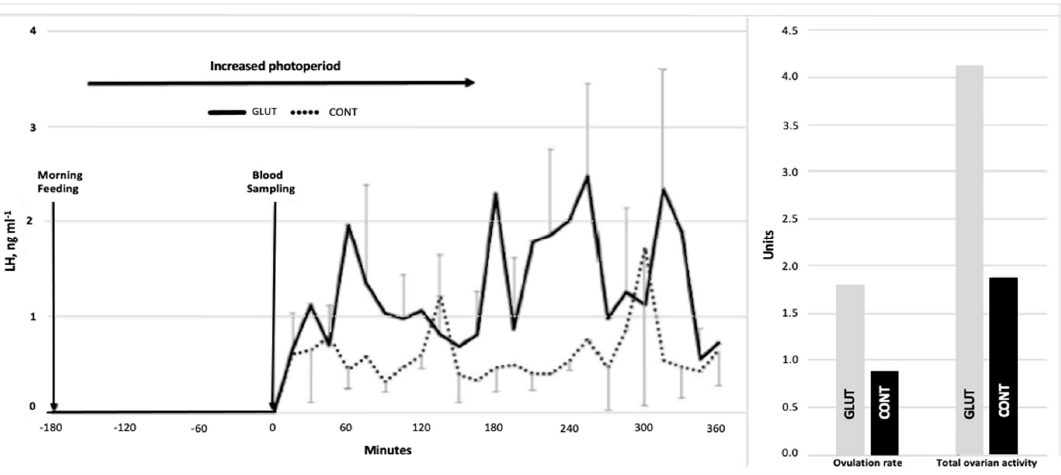
Figure 2. Serum LH concentrations (ng/mL) across time ( left ), and OR (units) and TOA (units) ( right ) in glutamate-supplemented (GLUT) and non-supplemented (CONT)